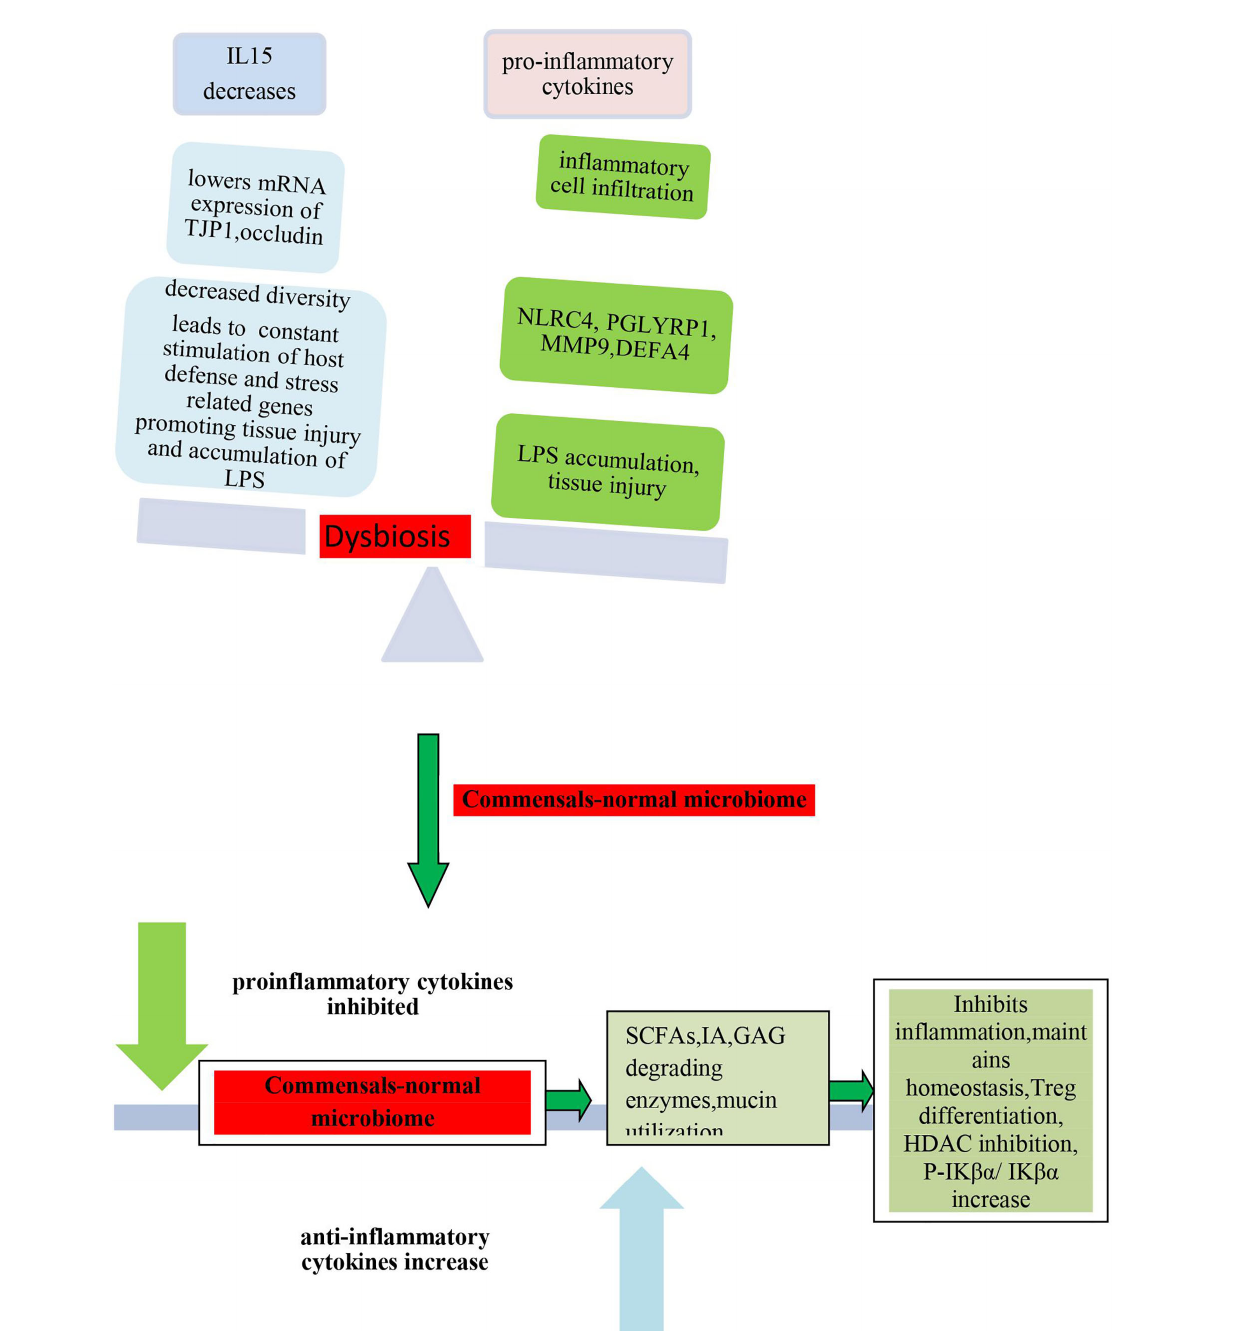
Frontiers in Cellular and Infection Microbiology |